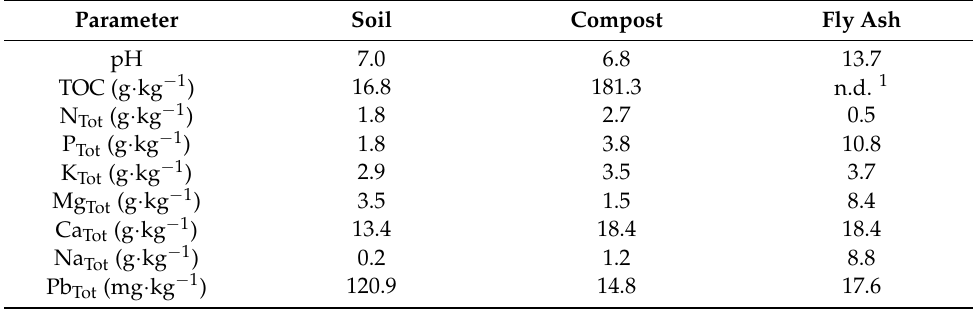
Table 1. Basis properties of soil, compost and fly ash (data for composite